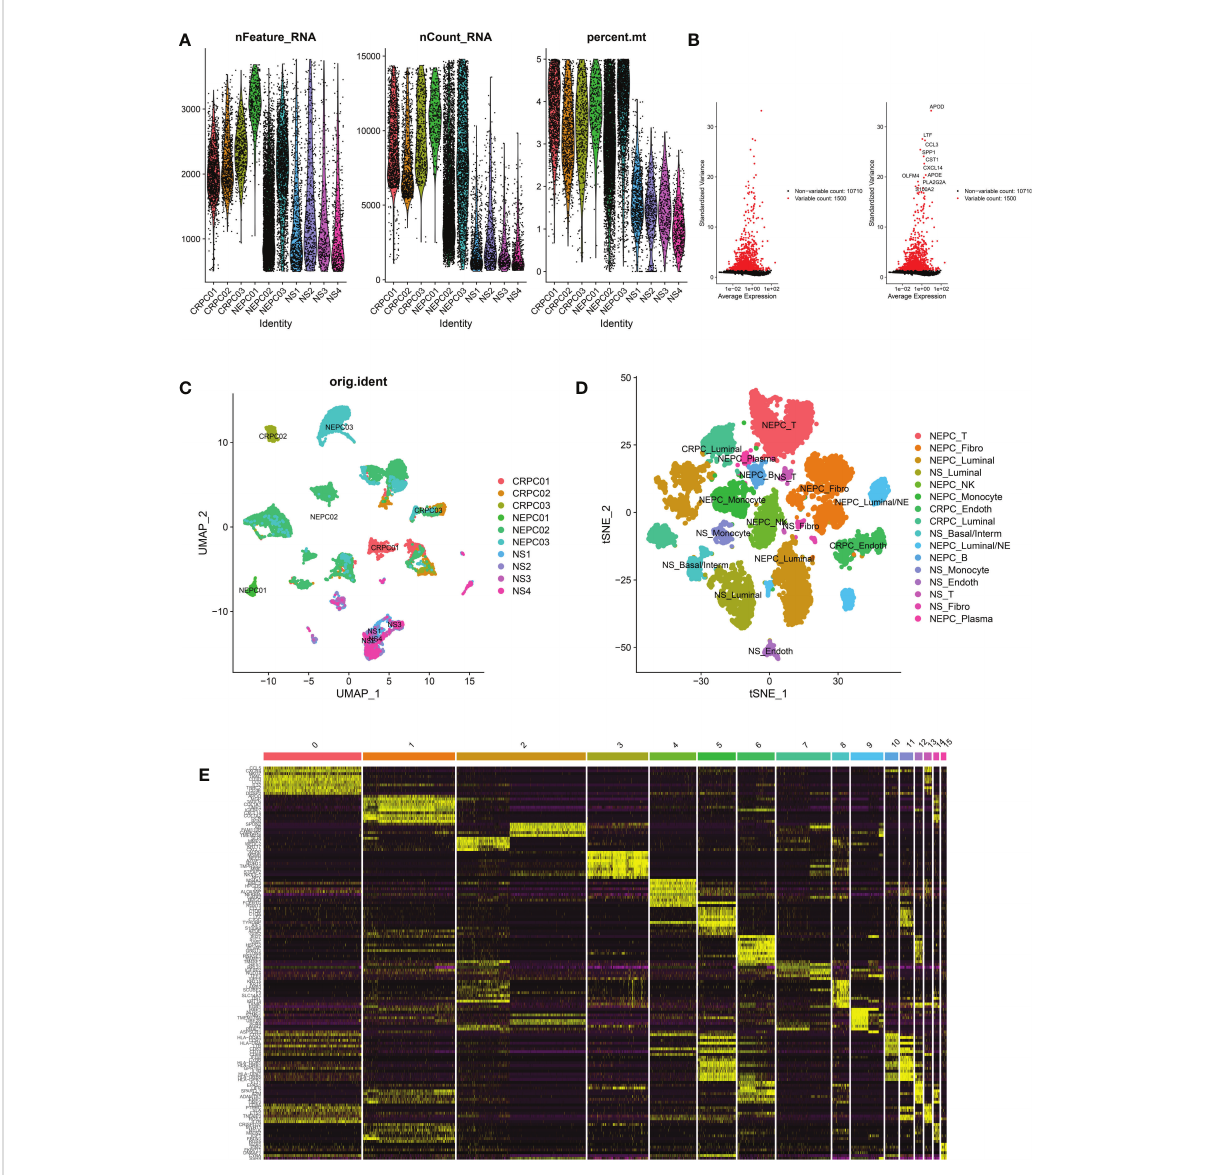
FIGURE 3 Analysis of single-cell RNA seq of 3 CRPC tissues, 3 NEPC tissues and 4 NS tissues. CRPC, castration resistant prostate cancer; NEPC, neuroendocrine prostate cancer; NS, negative samples; Fibro, Fibroblast; Basal/interm, Basal/intermediate; Endoth, endothelial; (A) : the number of RNA features (nFeature_RNA) and absolute UMI counts (nCount_RNA) after quality control fi ltering of each cell. (B) : We explored 1,500 high variable genes that exhibit high cell-to-cell variation, and the names of the top 10 genes are marked. (C) : Using UMAP dimensionality reduction algorithm, 12165 cells from 10 samples were displayed. (D) : Cells were classi fi ed into 16 clusters via t-SNE dimensionality reduction algorithm based on the source of the cluster, each cluster was marked with the source of the cluster plus the annotated cell types. There may exist 2 same cell types in 16 clusters. (E) : Heatmap depicting expressions of top 10 marker genes among 16